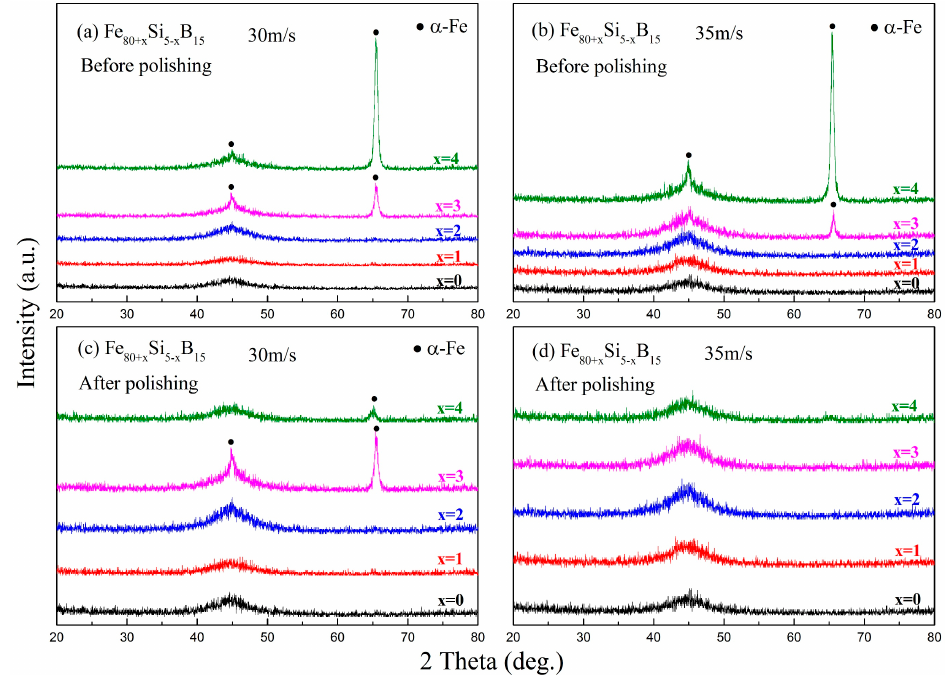
Figure 5. XRD patterns for the free surface of the Fe 80+x Si 5 − x B 15 ( x = 0–4) melt-spun ribbons ( a , b ) before and ( c , d ) after polishing the surface layer. The alloys are prepared with a linear velocity of 30 or 35 m/s.